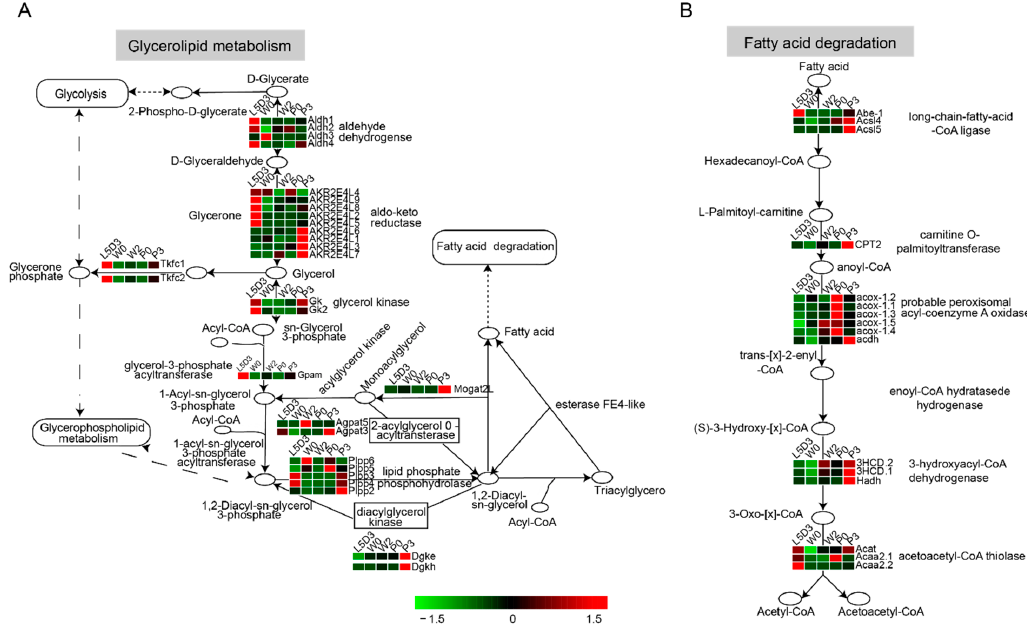
Figure 5. DEGs involved in glycerolipid metabolism and fatty acid degradation pathway. ( A )